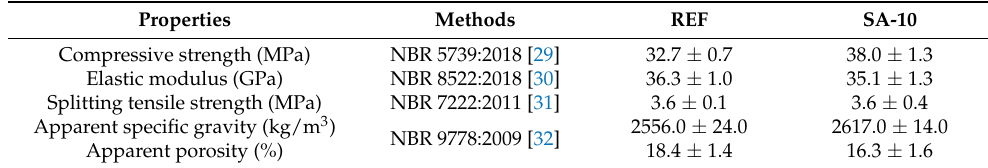
Table 3. Physical and mechanical properties of concrete at 28